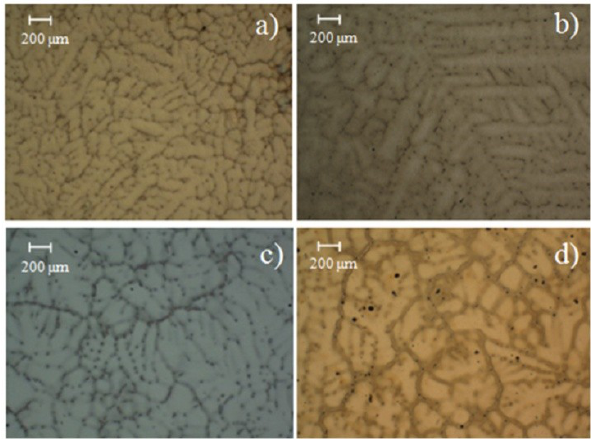
Figure 1. Optical micrographs showing the microstructure of ( a ) Mg-0.375Ga, ( b ) Mg-0.75Ga, ( c ) Mg-1.125Ga, and ( d ) Mg-1.5Ga as-cast alloys.